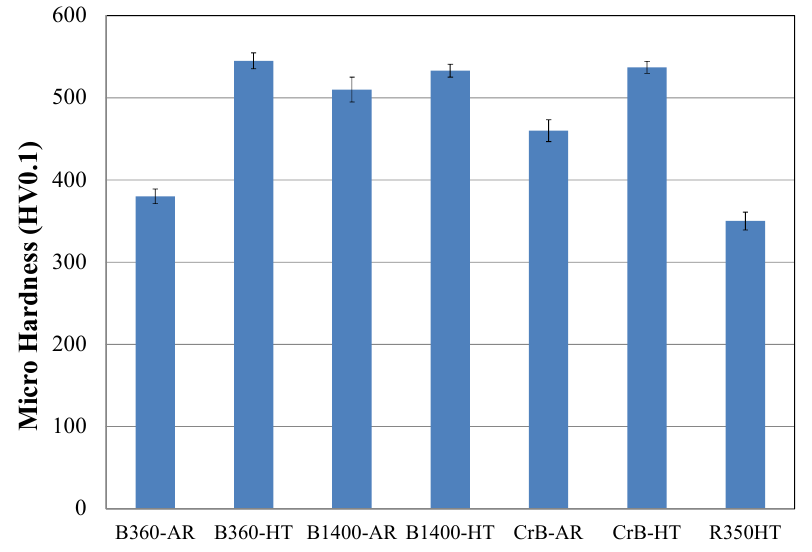
Figure 6. Hardness of all steels (HV0.1).